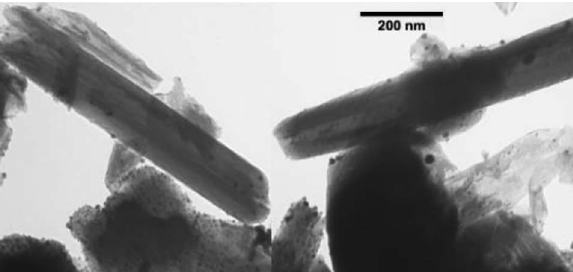
Fig 6. TEM image of Ag/HNTs.